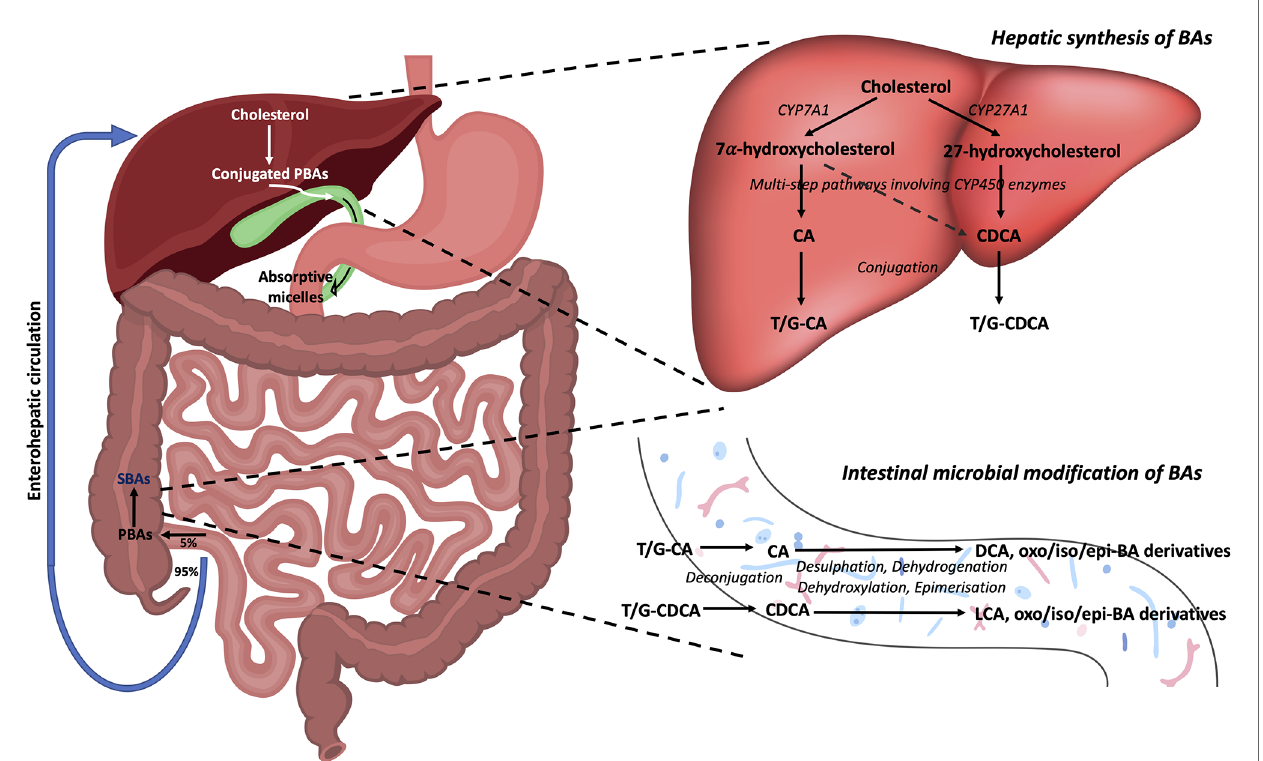
FIGURE 1 | Bile acid synthesis, recirculation and microbial modi fi cations in the gut. Bile acids are synthesised in the liver from cholesterol. In the classical pathway, cholesterol 7 a -hydroxylase (CYP7A1) converts cholesterol to 7 a -hydroxycholesterol which can then form either of the PBAs, CA and CDCA, through multistep pathways involving cytochrome P450 enzymes. In the alternative pathway, sterol-27-hydroxylase (CYP27A1) initiates the conversion of cholesterol to 27- hydroxycholesterol which mainly forms CDCA. These PBAs are then conjugated with either taurine (T) or glycine (G) to make them water soluble, before being released into bile where they form mixed micelles. As bile enters the duodenum via the ampulla of Vater, absorptive micelles are formed which facilitates the absorption of fatty acids, monoglycerides, fat soluble vitamins, and cholesterol in the small intestine. In the terminal ileum, 95% of conjugated BAs are reabsorbed through the enterohepatic circulation, whilst the remaining 5% enter the colon. Here, BAs undergo a number of chemical modi fi cations by gut bacteria including deconjugation, desulphation, dehydrogenation, dehydroxylation, and epimerisation reactions to form the SBAs, LCA and DCA, and their oxo, iso, and epi-derivatives. PBAs, primary bile acids; SBAs, secondary bile acids; CA, cholic acid; CDCA, chenodeoxycholic acid; DCA, deoxycholic acid; LCA, lithocholic acid; T, taurine; G, glycine; CYP7A1, 7 a -hydroxylase; CYP27A1,